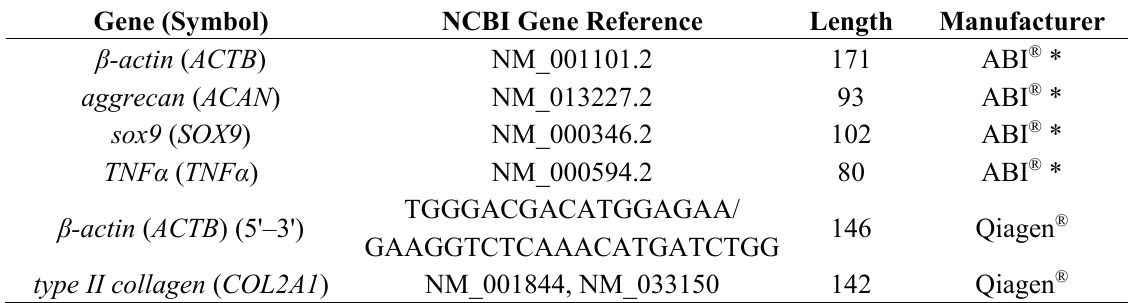
Table 3. Sequences of the primers used in the present